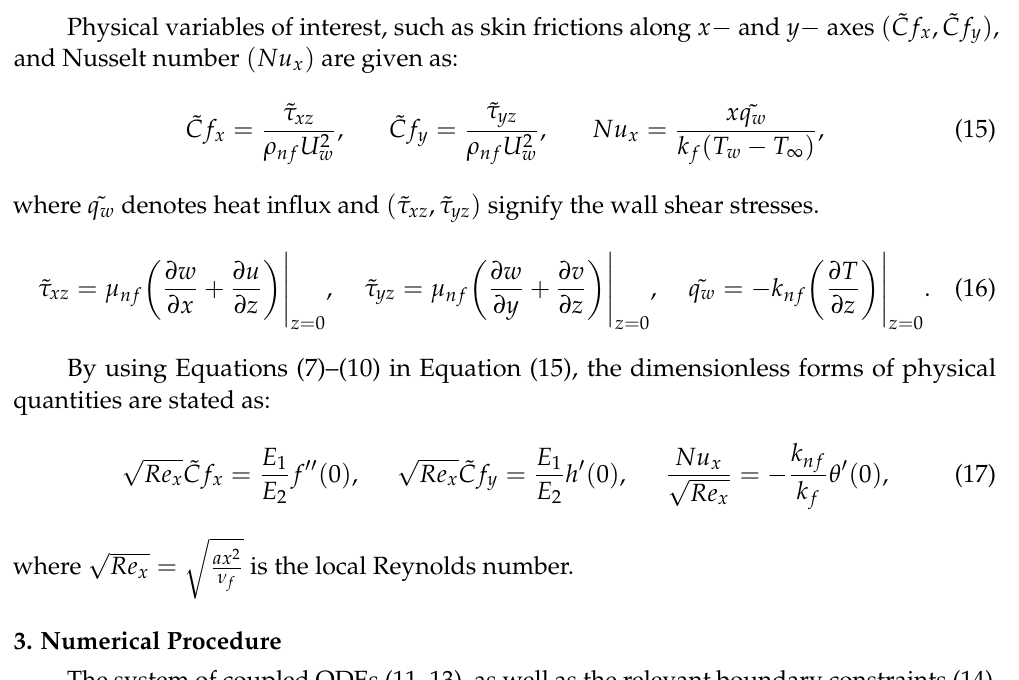
Figure 2. Shape of nanoparticles along with shape factor